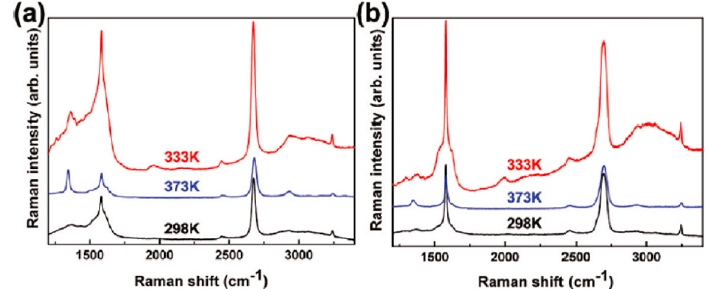
Figure 28. Raman spectra of monolayer ( a ) and bilayer ( b ) graphene covered by 5 nm Ag deposited maintaining the substrate at 298 K (black line), 333 K (red line), and 373 K (blue line). Reproduced from Reference [71] with permission from the American Chemical Society.